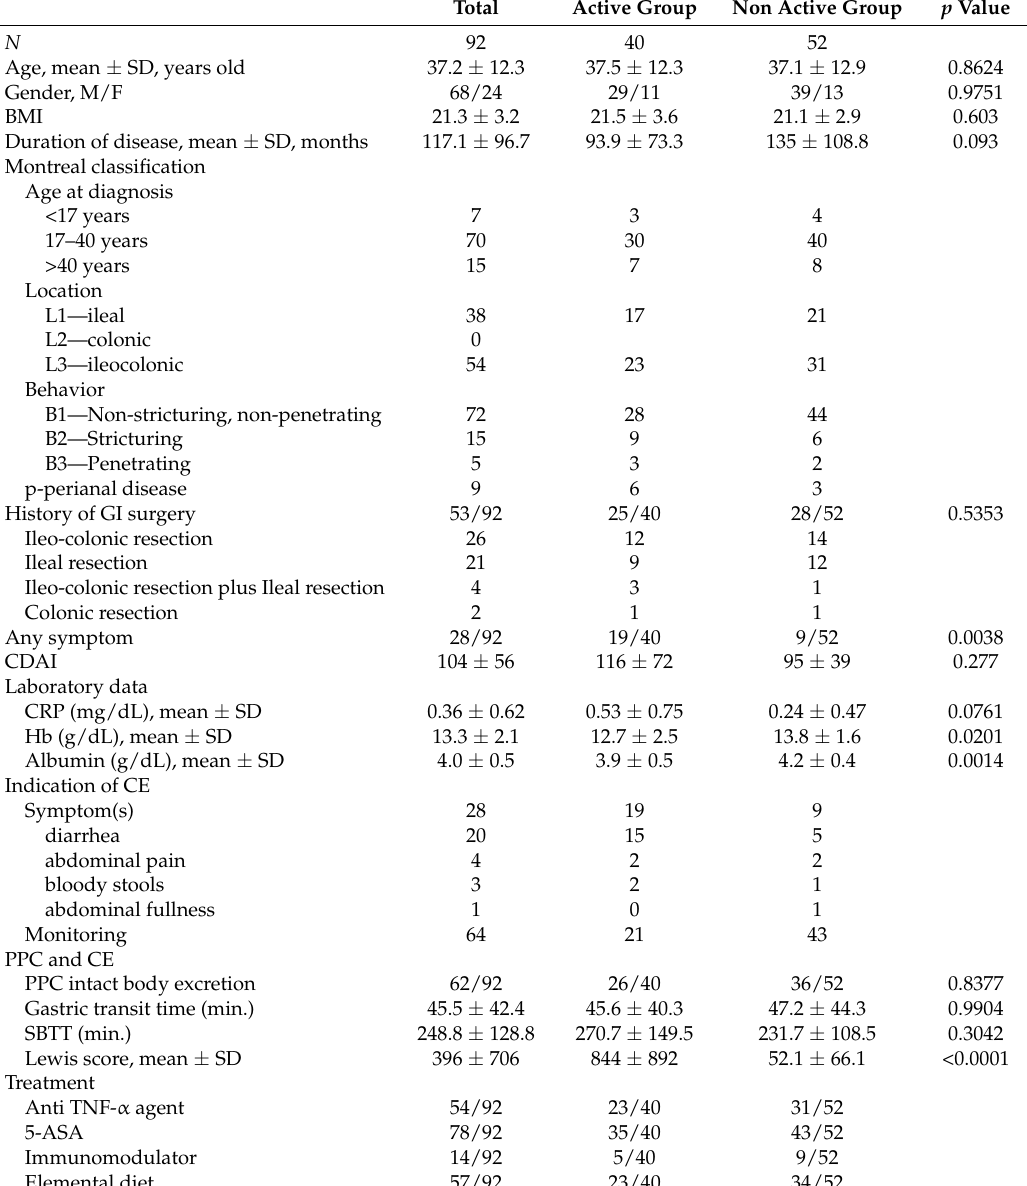
Table 1. Demographic data of the patients at the point of study